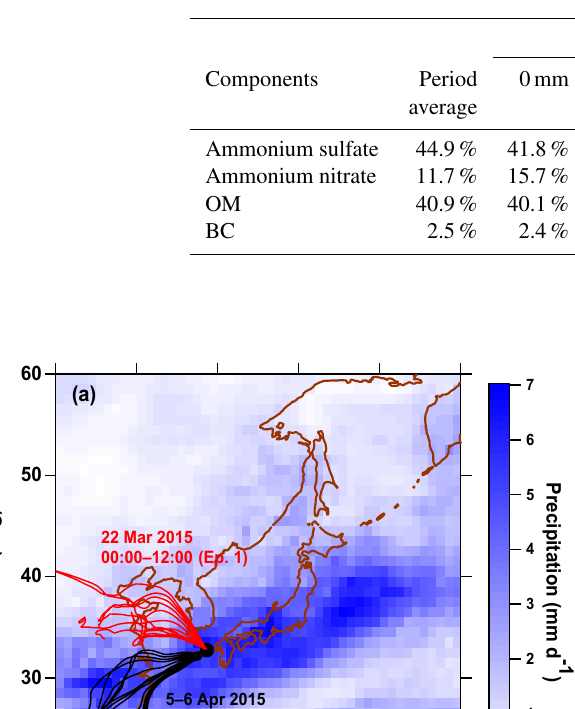
Table 1. Mean chemical composition of fine aerosols during the observation period.